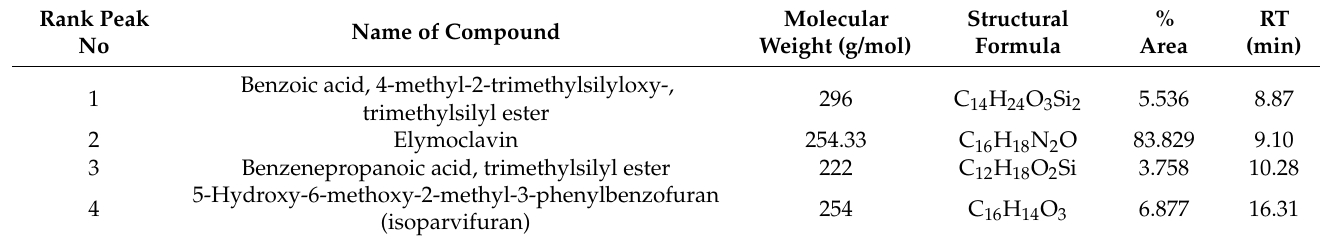
Table 3. GC-MS identified compounds in the n-butanol fraction of C. europaea . Rank